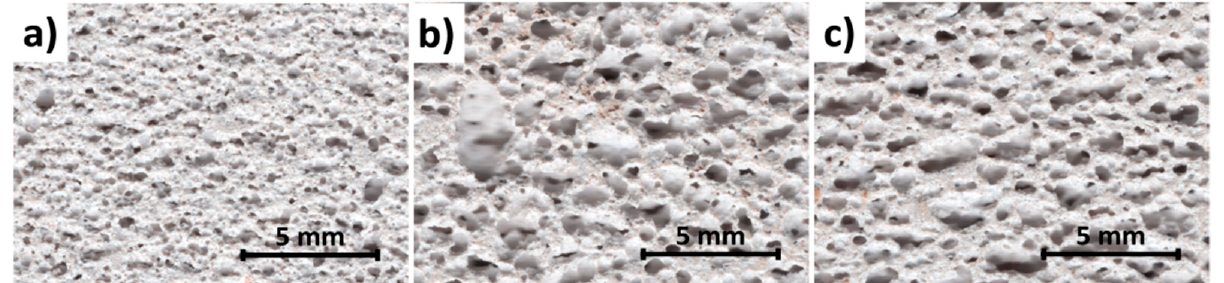
Figure 4. The porous microstructure of the investigated AAC samples: ( a ) reference sample;